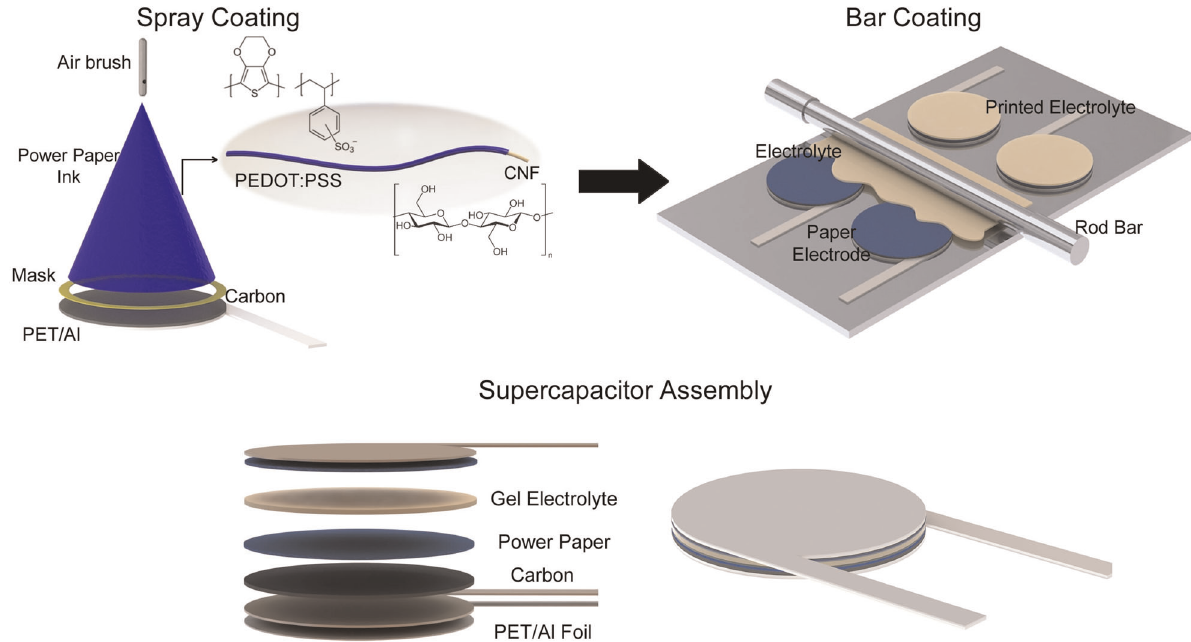
Fig. 1 Fabrication scheme of spray-coated printed paper supercapacitor. Schematics represents the printing steps and components of the paper